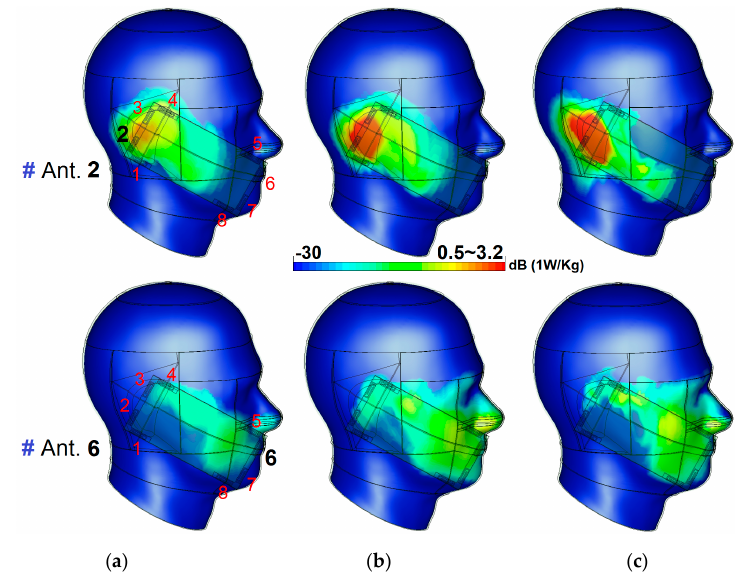
Figure 17. SAR for antennas 1 and 5 at ( a ) first (2.6 GHz), ( b ) second (3.6 GHz), and ( c ) third (5.8 GHz) resonances. Table 3. Characteristics of the smartphone components.